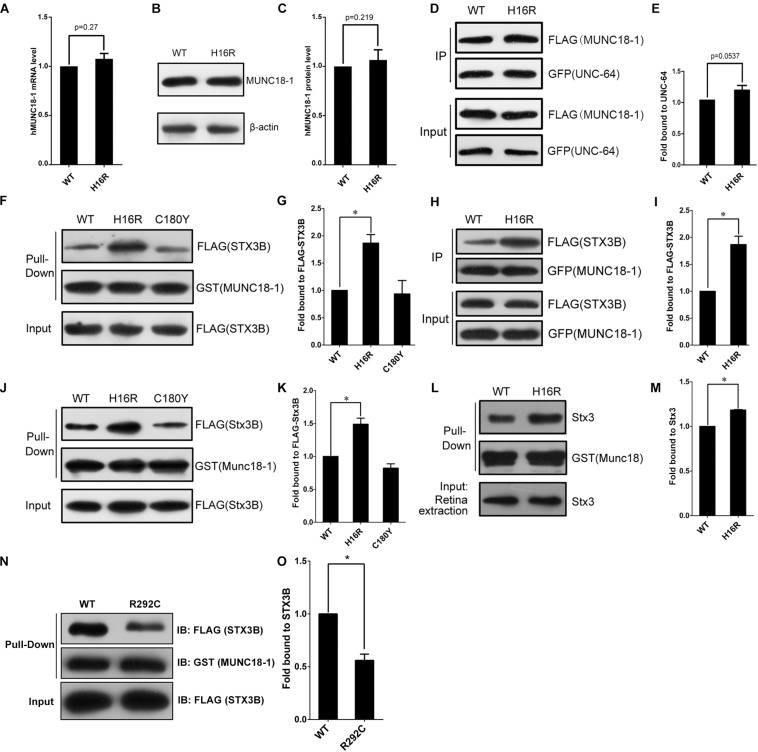
The MUNC18-1 p.His16Arg mutant shows altered interaction with human and mouse syntaxin 3. (A) Wild-type and p.His16Arg mutant hMUNC18-1 transgenic e81 worms show similar hMUNC18-1 mRNA expression levels detected by RT-qPCR (n = 3, p = 0.27). (B,C) Western blot demonstrates similar levels of WT and p.His16Arg mutant hMUNC18-1-GFP fusion protein in transgenic e81 worms (n = 3, p = 0.219). (D,E) Co-immunoprecipitation assay of FLAG-tagged WT and mutant MUNC18-1 with GFP-fused UNC-64, p.His16Arg mutant protein shows slight enhanced binding of to UNC-64 compared with WT (n = 5, p = 0.0537). The data are represented as the mean ± SD. Statistical significance was evaluated using two-tailed t-test. (F,G) GST pull-down assay of GST-tagged wild-type and mutant MUNC18-1 with the FLAG-tagged human STX3B. The p.His16Arg mutant exhibits obviously enhanced affinity for STX3B compared with WT, while the p.C180Y mutant shows similar affinity compared with WT. The experiments were repeated 3 times independently, * means p < 0.05. (H,I) GFP tagged wild-type and p.His16Arg mutant MUNC18-1 were co-transfected into HeLa cells with FLAG-tagged human STX3B. Cell extracts were immunoprecipitated with anti-GFP antibody and analyzed by immunoblotting with anti-FLAG antibody. The p.His16Arg mutant shows overt intensive interaction with human STX3B compared with WT. The assays were repeated 3 times independently, * means p < 0.05. (J,L) GST pull-down assay of GST-tagged mouse WT and mutant Munc18-1 with the FLAG-tagged mouse Stx3B or endogenous Stx3 (mouse retina extracts). (K,M) Quantitative analysis of the interaction between GST-Munc18-1 and FLAG-Stx3B or endogenous Stx3 based on the data shown in (J,L), respectively, * means p < 0.05. (N,O) GST pull-down assays show that p.R292C mutant which cause EIEE4 associated with nystagmus exhibits decreased binding affinity to the FLAG-STX3B fusion protein compared to wild-type MUNC18-1, the assays were repeated 3 times independently, * means p < 0.05.